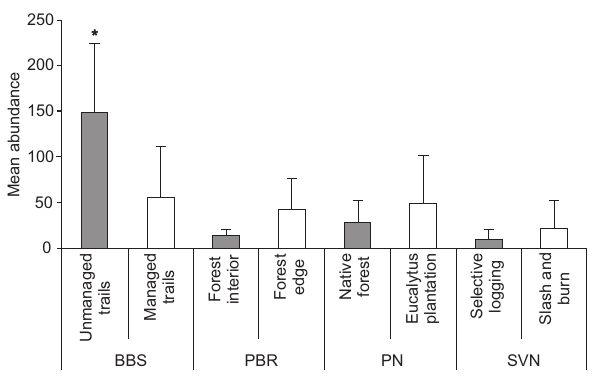
Figure 3. Mean abundance of isopods in the contrasting sites of the four protected areas sampled. Gray and white bars indicate less and more disturbed sites in the same protected area, respec- tively. * = permutation t-test, p < 0.05. (BBS) Boracéia Biological Station, (PBR) Paranapiacaba Biological Reserve, (PN) Parque das Neblinas, (SVN) Santa Virgínia nucleus.